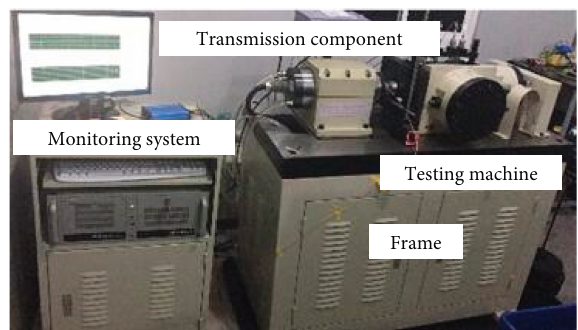
Figure 3: Reliability test bench of axle journal